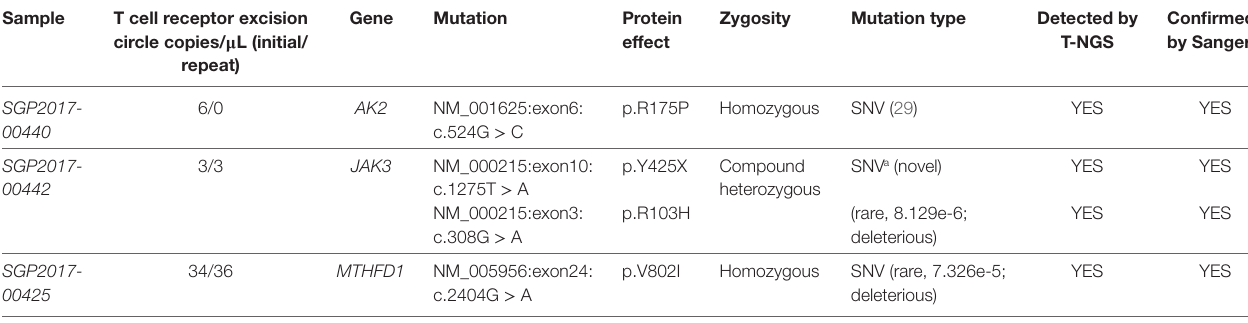
TaBle 1 | Mutations detected by T-next generation sequencing (NGS) primary immunodeficiency disease panel.